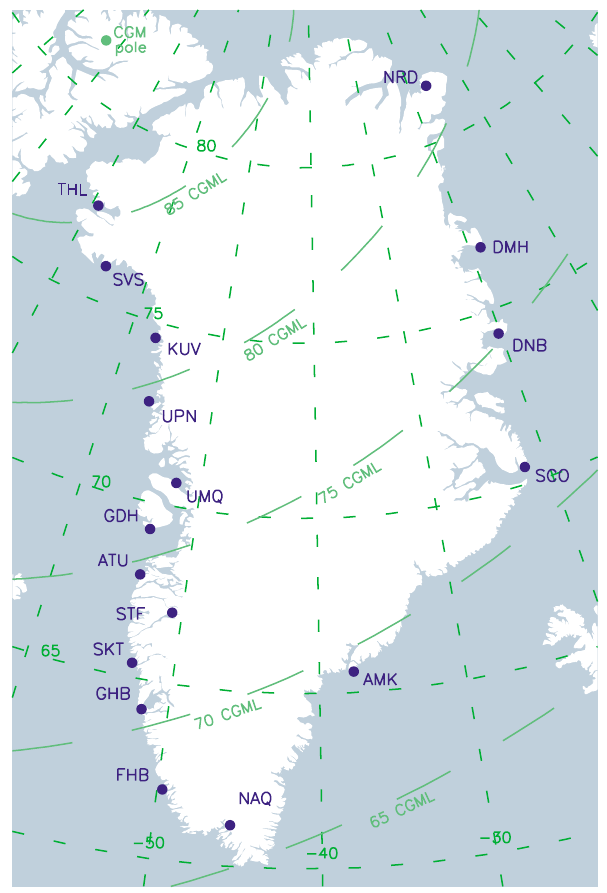
Fig. 1. A map of the Greenland stations used in the study is shown. Stations are named by their three-letter IAGA acronym. Corrected geomagnetic latitude curves as well as the approximate location of the geomagnetic pole are included for